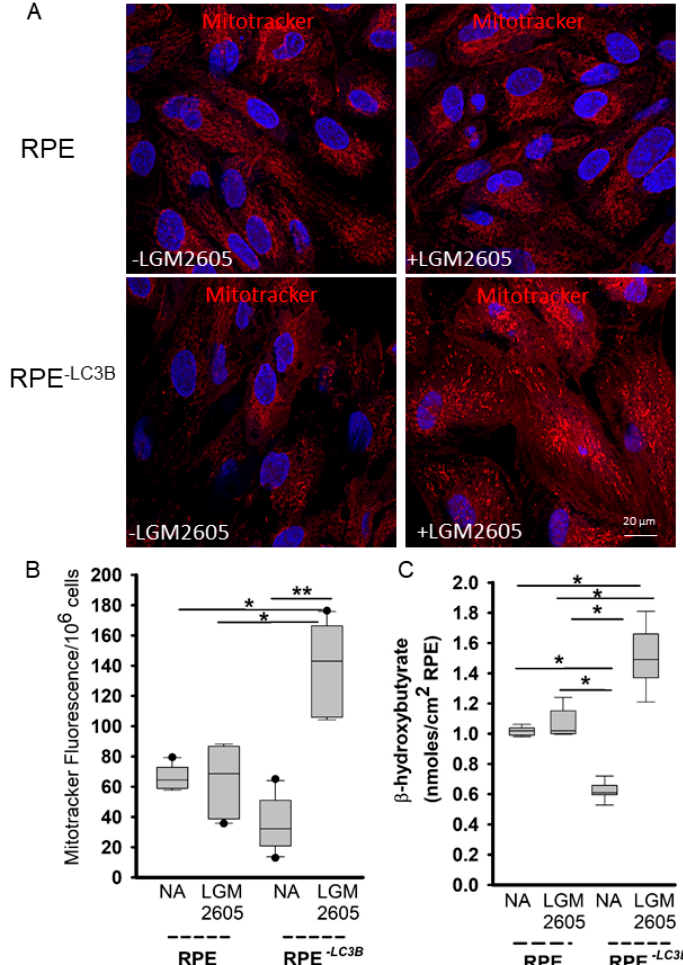
Figure 4. LGM2605 corrects lipid overload mediated mitochondrial stress ( A – C ). ( A ) Representative confocal image of mitochondria (red) detected by staining with Mitotracker Red and nuclei (blue) stained with Hoechst 33342 of RPE and RPE -LC3B cells at day 7 of OS treatment. 100 µ M LGM2605 was added in +LGM2605. ( B ) Mitotracker fluorescence was quantified. Plots show data for three independent experiments, each done in triplicate. Two-way ANOVA was used for comparison across the conditions tested, and post-hoc pairwise comparison using Holm–Sidak correction was used. For each independent experiment, we analyzed 5 fields of cells at 60X magnification. * indicates p < 0.050, ** indicates, p < 0.020. ( C ) RPE or RPE -LC3B cells were pretreated with 100 µ M LGM2605 and subsequently incubated with OSs and the apical supernatant was evaluated for β HB content after 2 h. Plots show data for three independent experiments, each done in triplicate. Two-way ANOVA was used for comparison across the conditions tested, and post-hoc pairwise comparison using Holm–Sidak correction was used. * indicates p < 0.050.